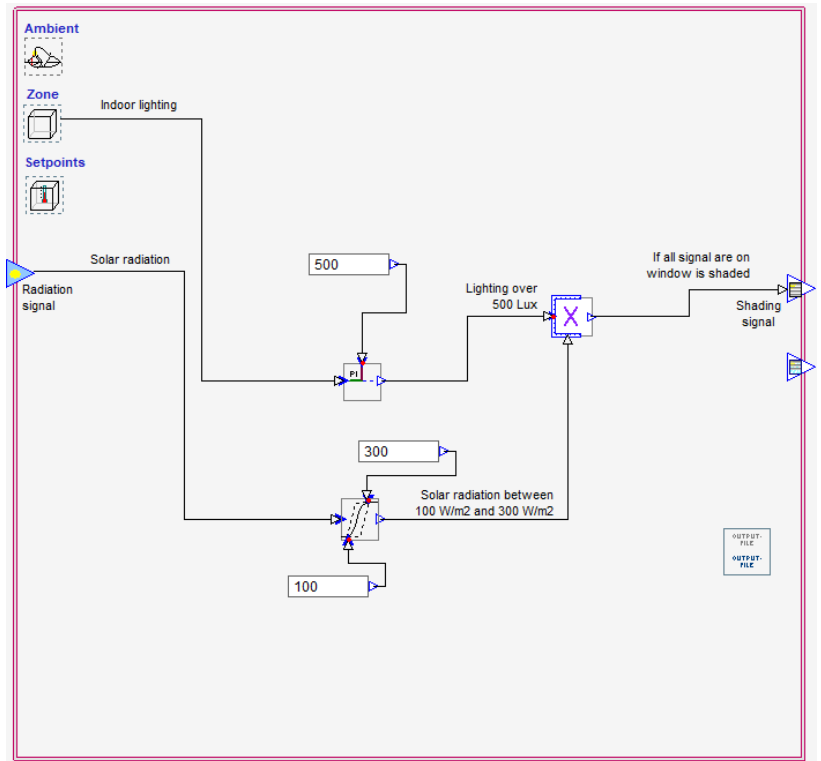
Figure A3. Control macro used for EC windows in design 5.